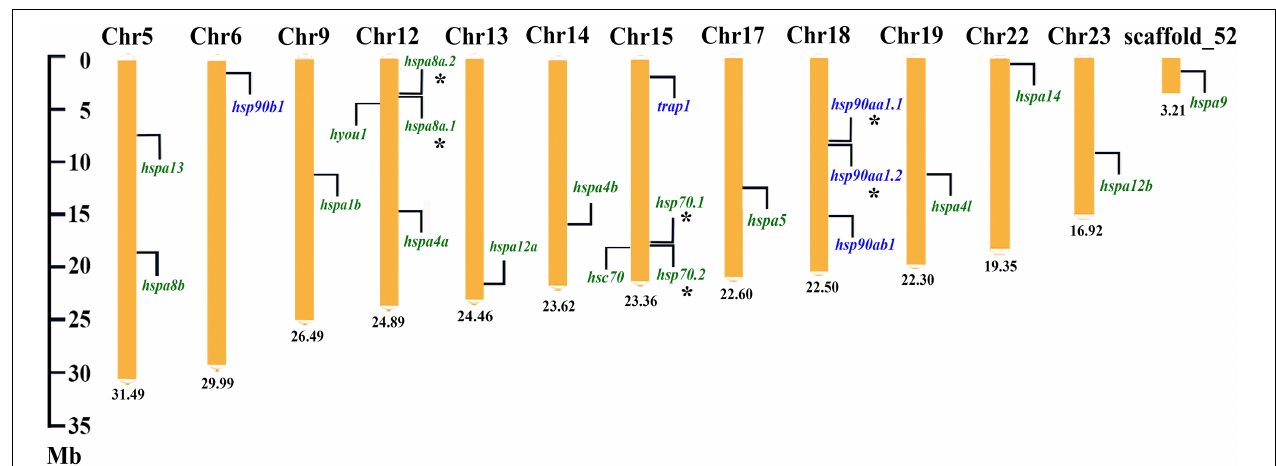
FIGURE 3 | Chromosome location of the HSP90 and HSP70 genes in spotted seabass. The HSP90 and HSP70 genes were indicated by the purple and green fonts, respectively. Asterisks (*) indicated tandem duplicated genes. The number at the bottom represented the length of the chromosomes or scaffold.